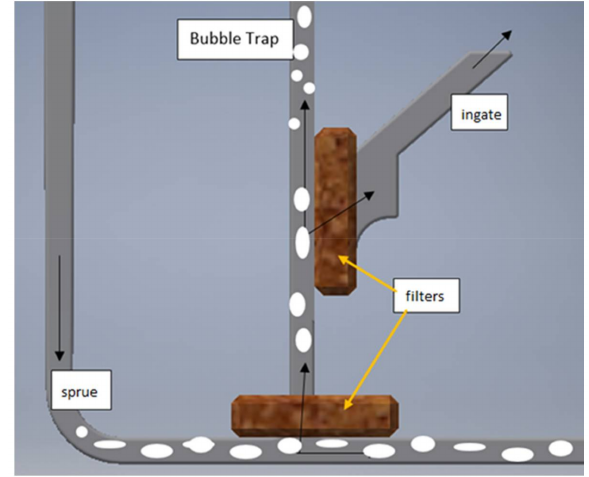
Figure 10. Trident gate system with filters.